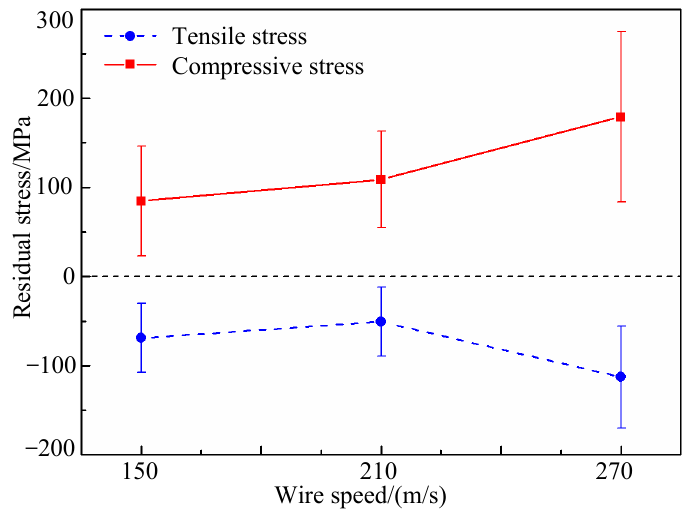
Figure 11. The change of residual stress with the increase of wire speed.